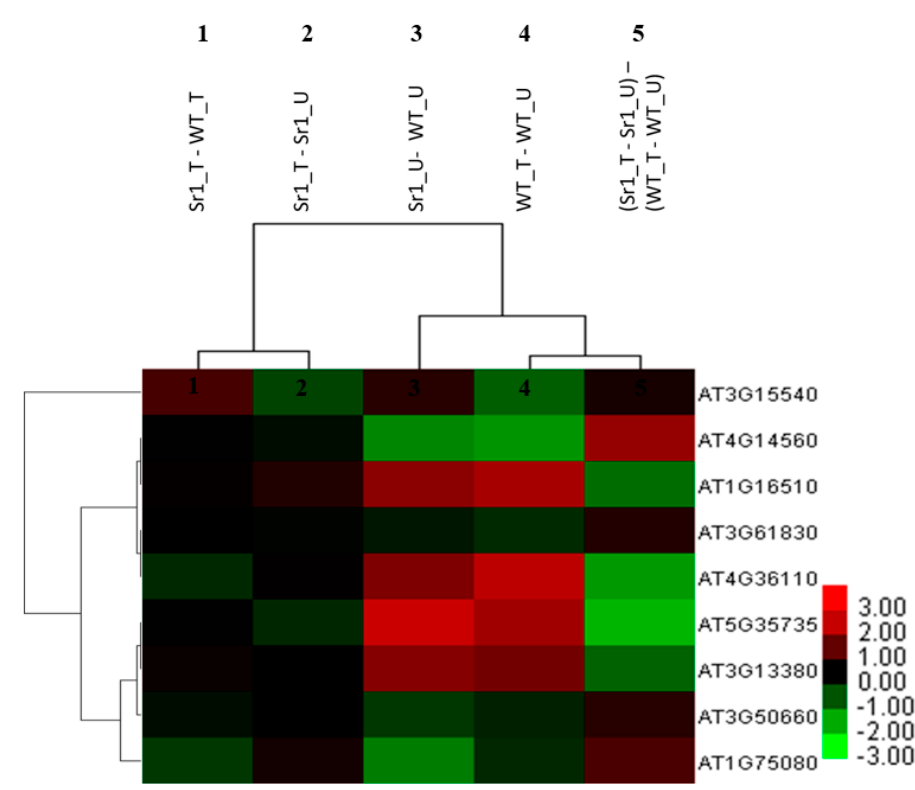
Figure 5. Hierarchical cluster analysis and heatmap indicating expression of growth-related DEGs between the genotype test and pathogen inoculation. The fold changes in gene expressions that increased and decreased in abundance are indicated in red and green, respectively. The intensity of colors increased as the difference in abundance increased. WT_U: absence of pathogen in WT; WT_T: 24 h after infiltration with Pst DC3000 in WT; Sr1_U: absence of pathogen in atsr1 mutants; Sr1_T: 24 h after infiltration with Pst DC3000 in atsr1